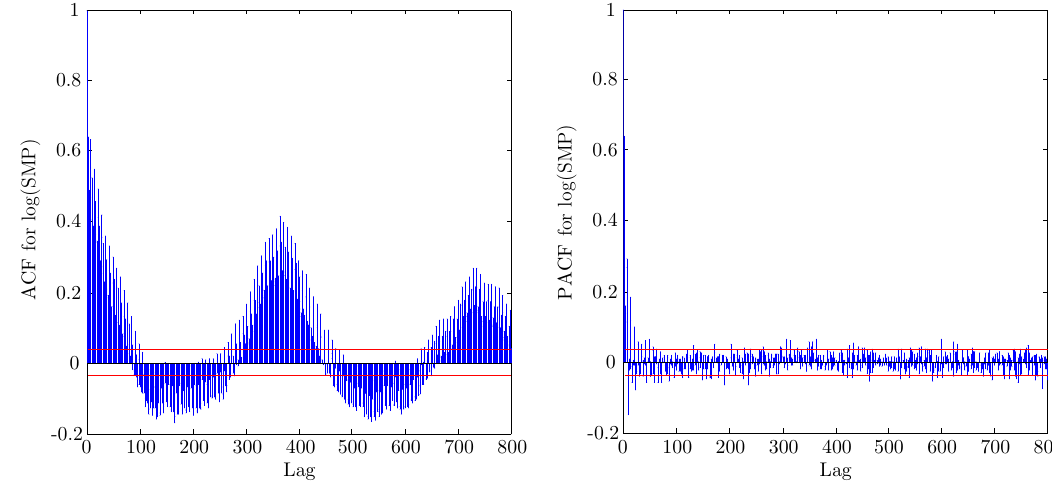
Figure 8. Correlogram for the log of the SMP time